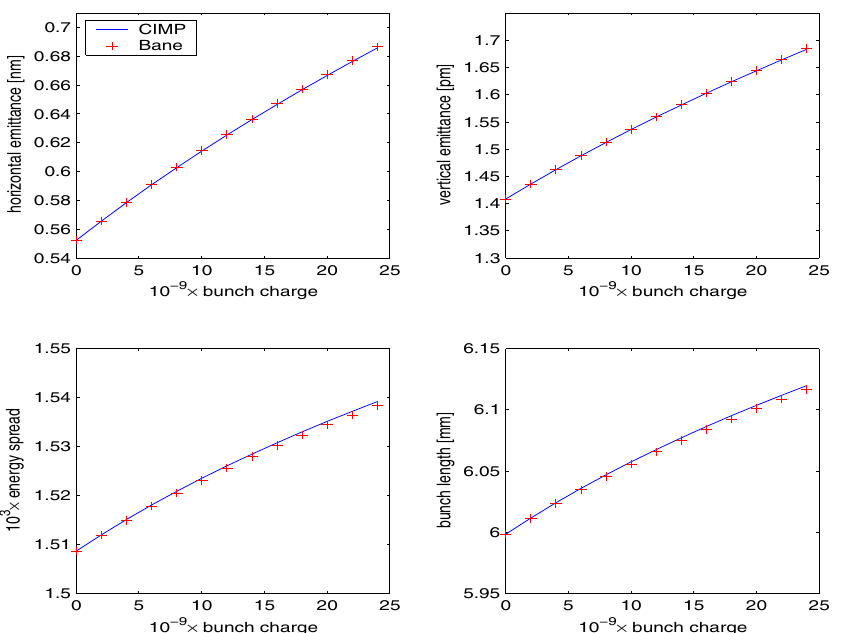
FIG. 2. (Color) Equilibrium transverse emittances, relative energy spread, and rms bunch length vs bunch charge for the ILC damping ring.